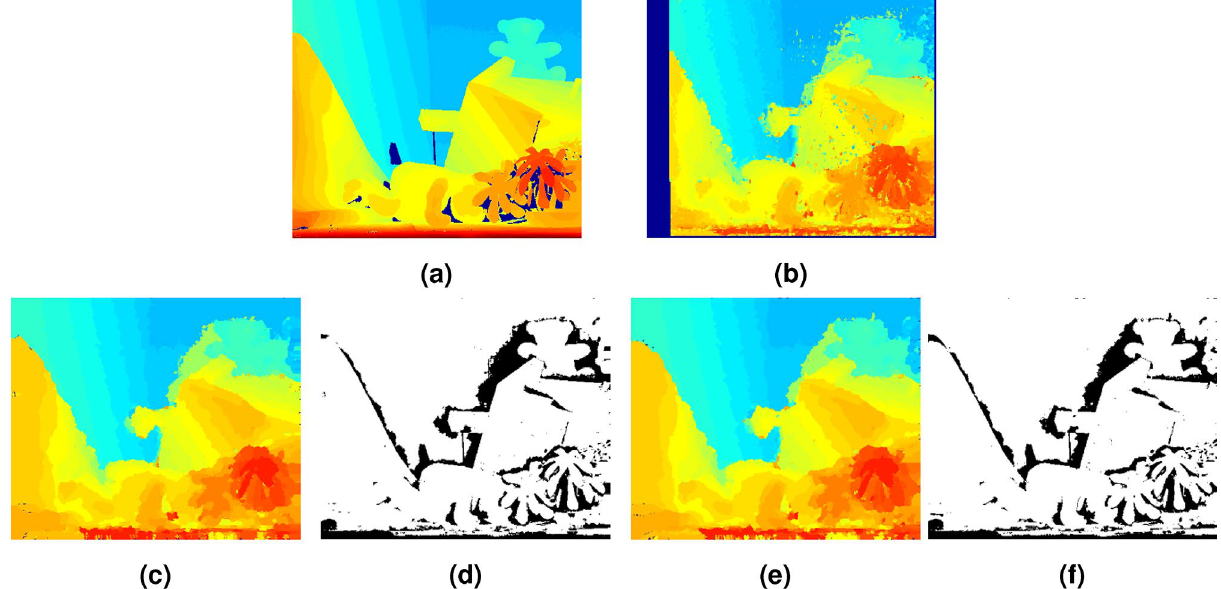
Figure 4. Effect of the edge-preserving filters on the accuracy of the disparity map for the “Teddy” stereo pair estimated using the FGS algorithm. Disparity estimates in the occluded regions are not excluded in the final disparity map. ( a ) Ground truth, ( b ) Initial disparity map, ( c ) Disparity map estimated using the FGS algorithm with guided filters, ( d ) Disparity error map for Fig. 4c, ( e ) Disparity map estimated using the FGS algorithm with bilateral filters, and (f) Disparity error map for Fig. 4e.